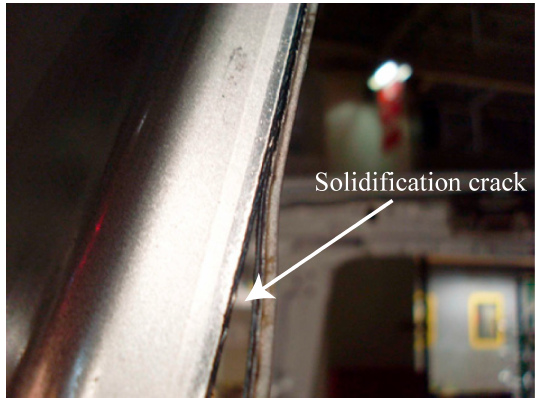
Figure 1. Solidification cracking in the B-pillar of a Volvo XC60 car body. With permission from [16].